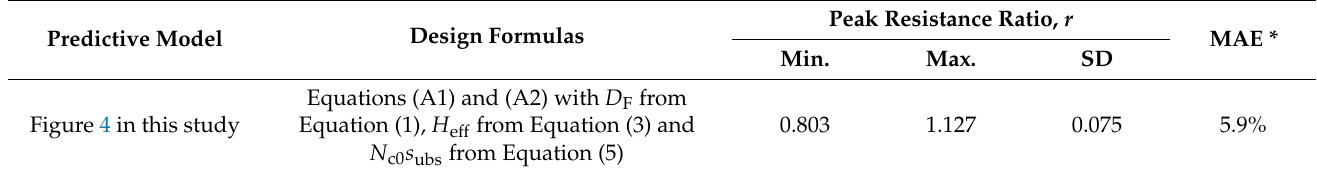
Table 3. Statistics for peak resistance ratios after parameter